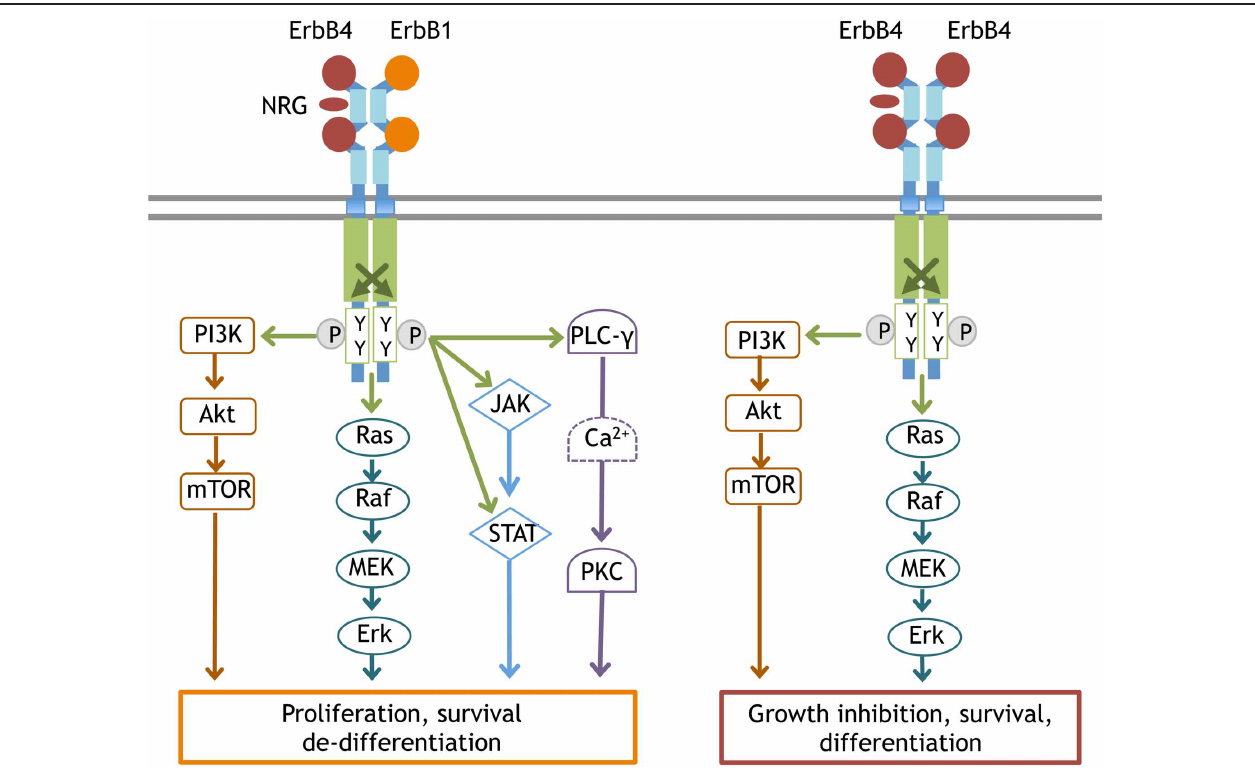
Erk(MAPK). (3) In the PI3K-Akt pathway, the activated ErbB dimer interacts with Grb2/Gab1 and forms complexes with activated PI3Kinase, leading to the conversion of PIP2 to PIP3 and Akt activation. (4) In the JAK-STAT pathway, ErbB kinase phosphorylates and induces JAK to bind to ErbB1. Activated JAK phosphorylates STAT and allows STAT to homodimerize and translocate into the nucleus. Once ErbB4